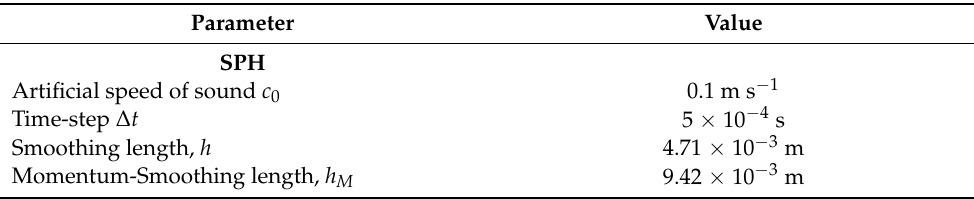
Table 5. Fundamental model